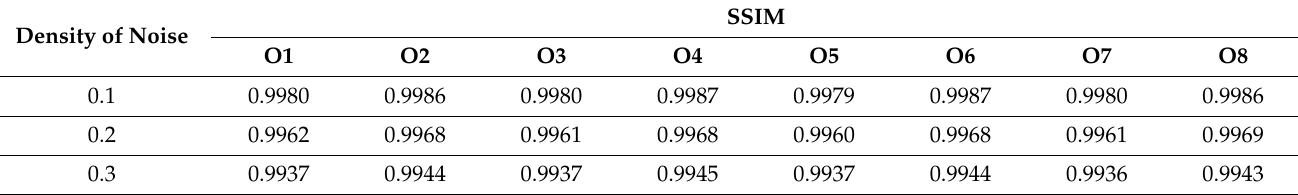
Figure 14. ( a – h ) The original eight fringe images; ( i – p ) the eight original images are restored again by filtering.